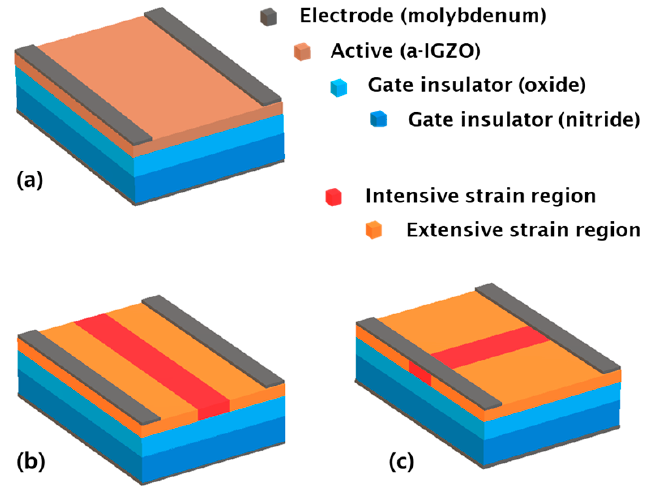
Figure 6. Schematic of device simulation structure: ( a ) Single-region structure with uniform DOS parameter for the active layer. ( b , c ) perpendicular and parallel multi-region structures consisting of intensive and extensive strain regions.